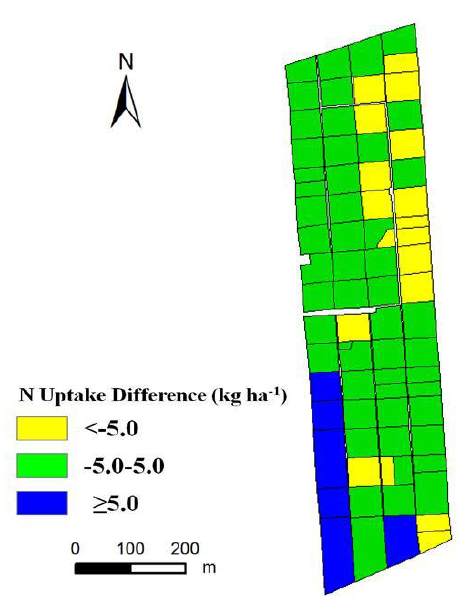
Figure 3. Examples of predicted rice nitrogen nutrition index (NNI) maps of two fields at the pixel level ( a ) and the plot-level ( b ), Heilongjiang Province, China.